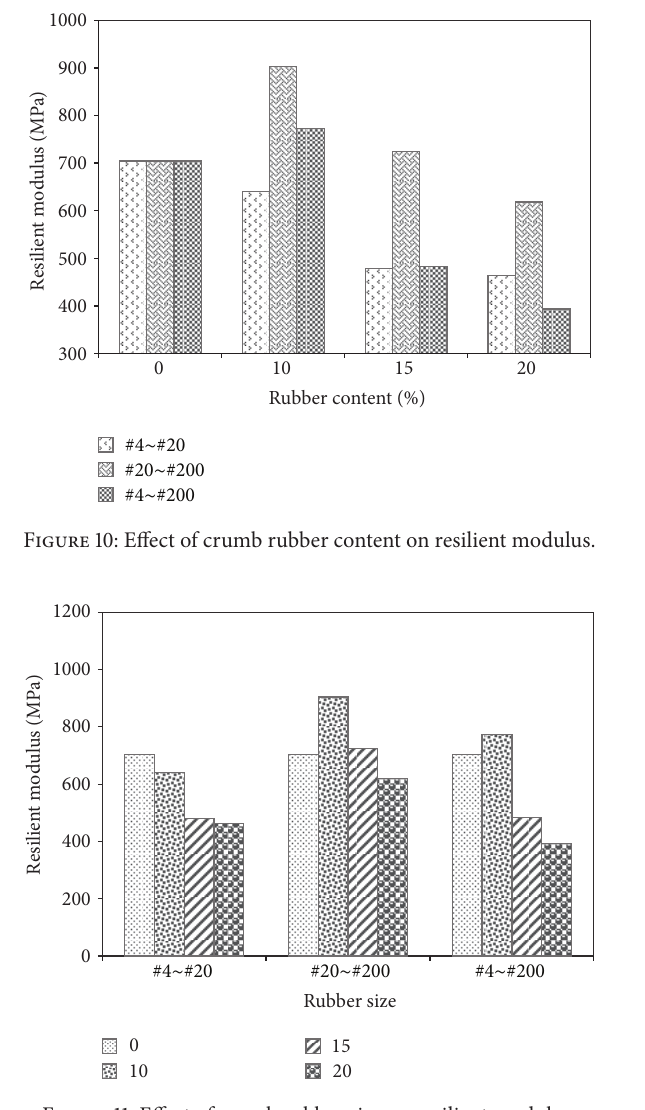
strength and Cantabro abrasion test results. Therefore, the impact of crumb rubber size and content on resilient modulus can be interpreted as noted